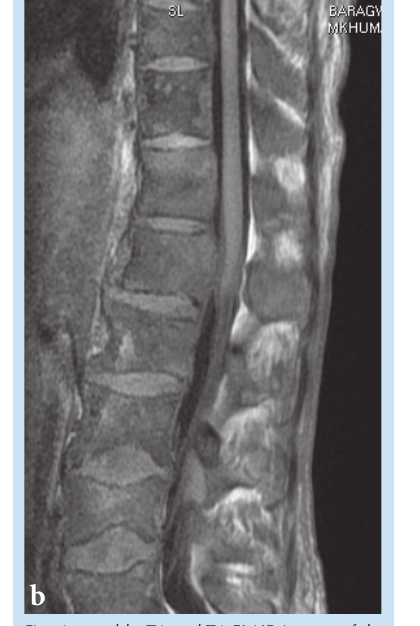
Figs 1 a and b: T1 and T1 FLAIR images of the L-spine.